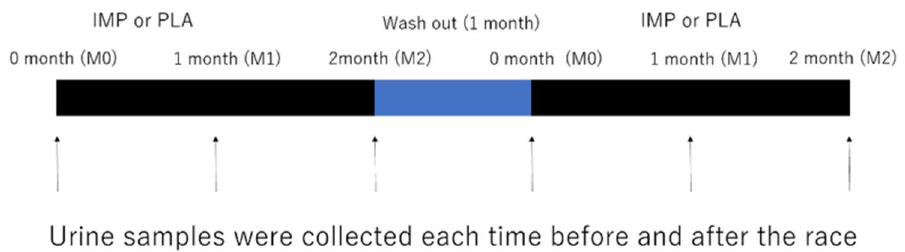
Figure 1. Experimental design. Immune protein powder (IMP) or a matched placebo (normal protein powder, PLA) were administered for 2 months in a cross-over randomized controlled trial (RCT). Arrows indicate the times at which 3000 m time trials were performed.